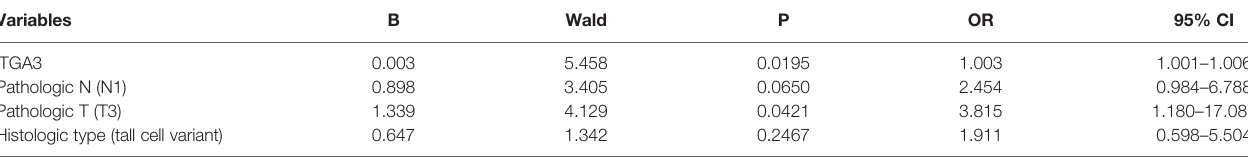
TABLE 3 | Binary logistic regression analysis with multiple factors for thyroid cancer recurrence. Variables B Wald P OR 95% CI ITGA3 0.003